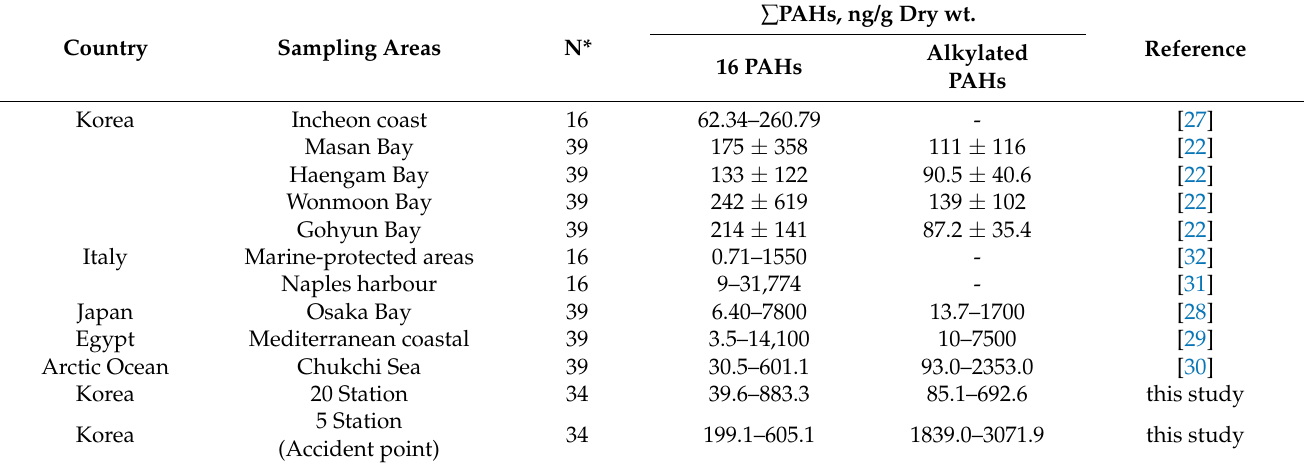
Table 5. Comparison of PAH concentrations in surface sediments between this and other